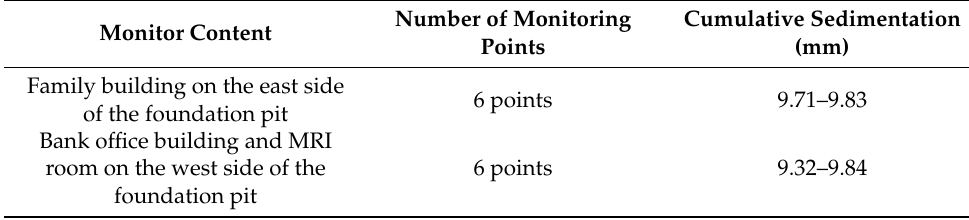
Table 4. Cumulative settlement by